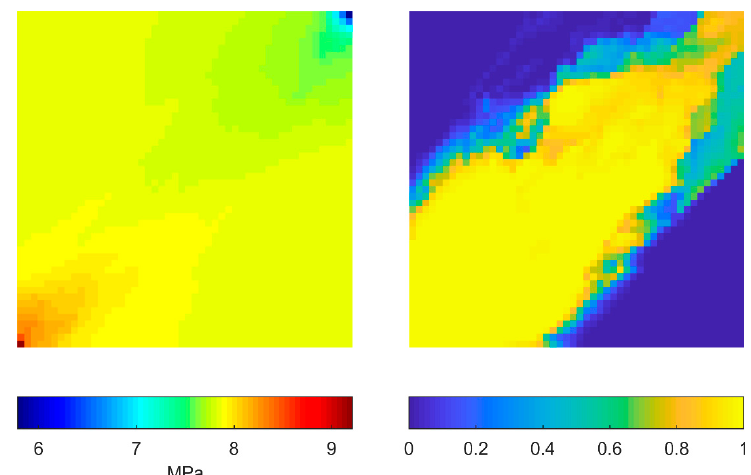
Figure 6. Reference solution for pressure distribution ( left ) and tracer concentration distribution after two pore-volume injection (2 PVI) ( right ).